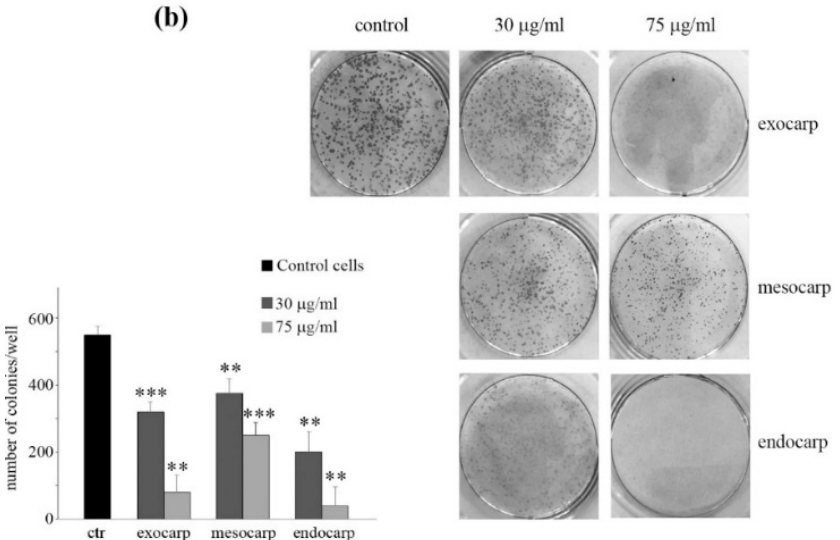
Figure 1. Effects of litchi extracts on HT29 cell viability and clonogenic ability. ( a ) Cells (7 × 10 3 ) were exposed to different doses of litchi extracts (left panel) or gallic acid (right panel) and the incubation was protracted for 48 h. Cell viability was then assessed by the colorimetric 3-(4,5-dimethyl-thiazol-2-yl)-2,5-diphenyltetrazolium bromide (MTT) assay as reported in the Materials and Methods. ( b ) Single cell suspensions (300 cells) were seeded in 6-well plates and were treated with two different doses of litchi extracts after 48 h. A clonogenic assay was carried out after eight days and the number of colonies was estimated as reported in the Materials and Methods. The results reported in the histograms are representative of three separate experiments. (*) p < 0.05; (**) p < 0.01; (***) p < 0.001 compared with control (ctr). n.s. not significant.